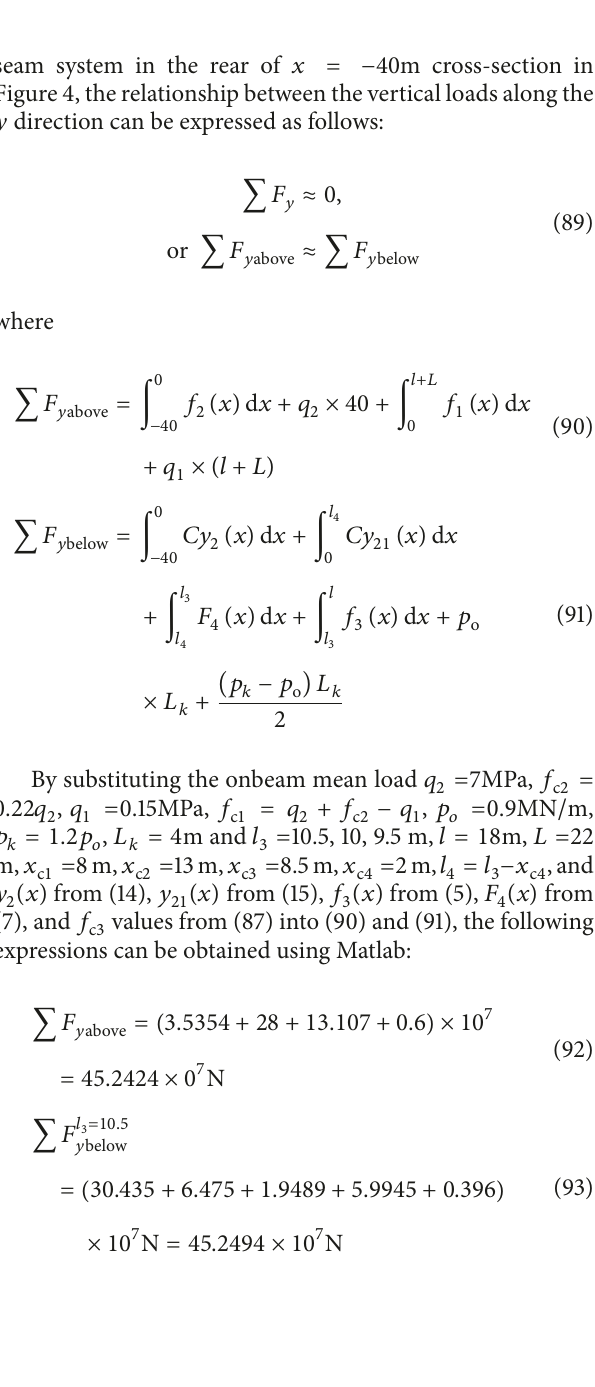
Figure 20: Abutment forces curves of coal seam with the increasing of the distance of overhang roof.